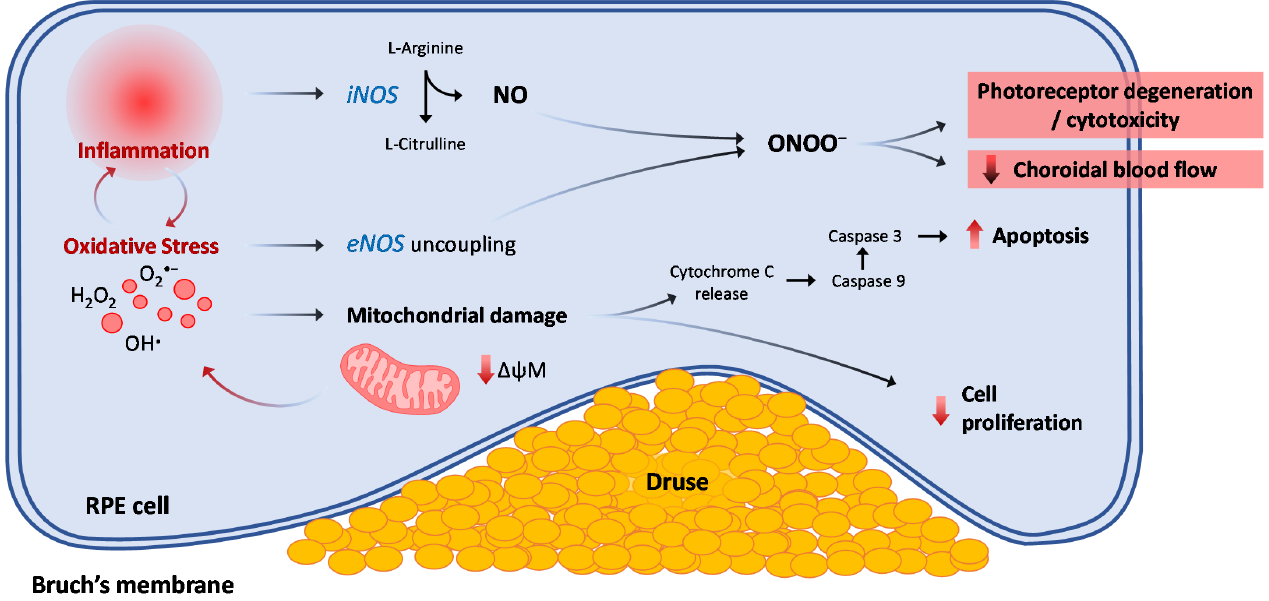
Figure 3. Schematic representation of the intracellular mechanisms leading to progressive changes observed in AMD as a consequence of oxidative and nitrosative stress. iNOS: inducible nitric oxide synthase; eNOS: endothelial nitric oxide synthase isoform; ONOO − : peroxinitrites; ROS: reactive oxygen species; Δψ M: mitochondrial membrane potential; AMD: age-related macular degeneration.